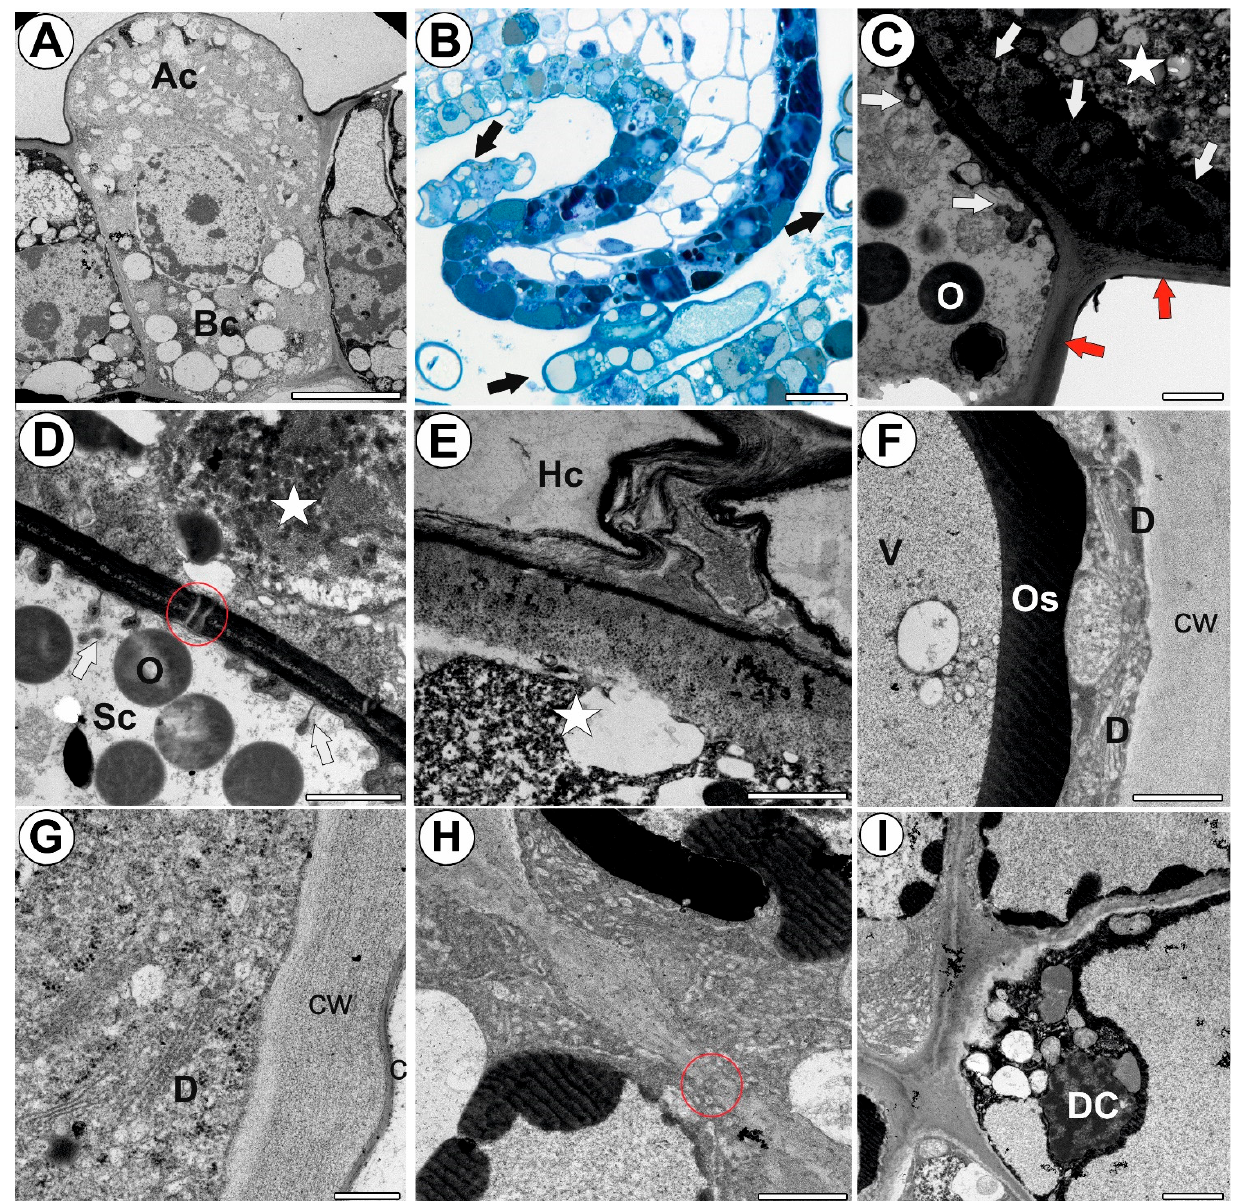
Figure 3. Development and structure of the stellate trichomes of the Dionaea muscipula traps. ( A ) The two-celled stage of a trichome, basal cell (Bc) and apical cell (Ac), bar 300 nm (transmission electron microscopy-TEM). ( B ) Various stages in the development of stellate trichomes (arrows), bar 20 µm (light microscopy). ( C , D ) Ultrastructure of a stalk cell (Sc) and internal head cell (star); cell wall ingrowths (arrows), plasmodesma (red circle), and oleosome (O), bars 1000 nm each (TEM). ( E ) Ultrastructure of an outer head cell (Hc) and internal head cell (star), bar 100 nm. ( F , G ) A part of a section of an outer head cell; dictyosomes (D), vacuole (V), osmiophilic material (Os), cuticle (c) and cell wall (cw), bars 800 nm and 400 nm, respectively (TEM). ( H ) Ultrastructure of outer head cells; note the plasmodesma (red circle), bar 900 nm, (TEM). ( I ) Outer head cells, note the degenerating outer head cells (DC), bar 2000 nm, (TEM).